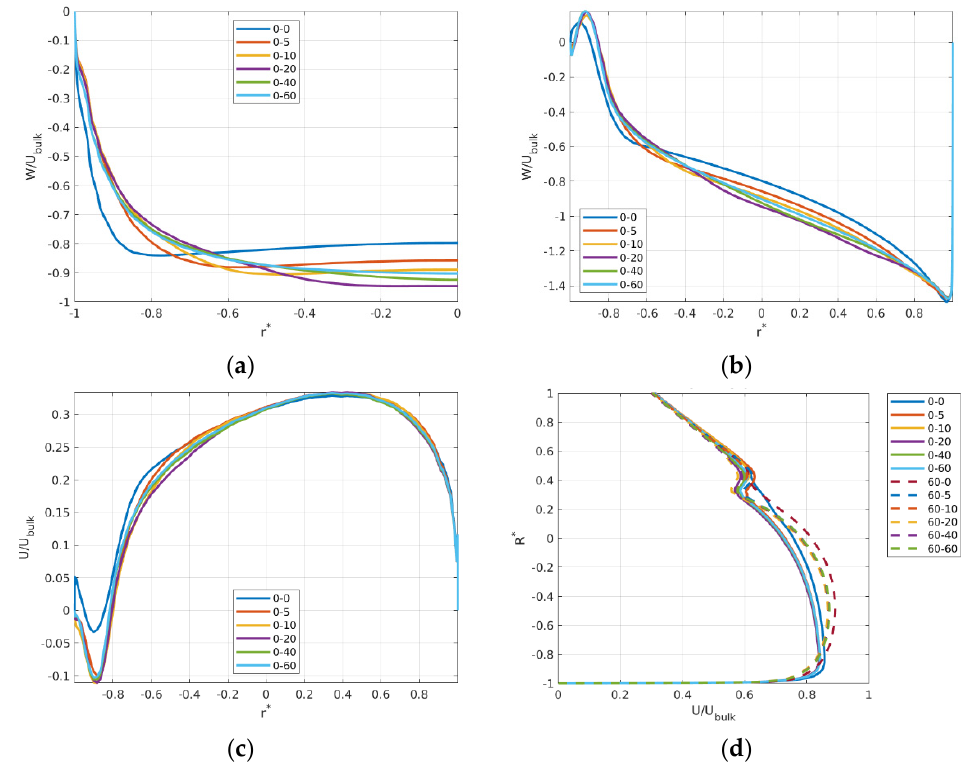
Figure 8. Profiles of ( a ) 𝑊 𝑈 (cid:3029)(cid:3048)(cid:3039)(cid:3038) ⁄ at 𝑧 = 0.07 m and 𝑥 = 0 and ( b ) 𝑊 𝑈 (cid:3029)(cid:3048)(cid:3039)(cid:3038) ⁄ at 𝑧 = 0.07 m and 𝑦 = 0, ( c ) 𝑈 𝑈 (cid:3029)(cid:3048)(cid:3039)(cid:3038) ⁄ at 𝑧 = 0.07 m and 𝑦 = 0—Cases with uniformly distributed BCs at the main inlet. ( c ) U / U bulk at z = 0.07 m and y = 0—Cases with uniformly distributed BCs at the main inlet. Subplot Subplot ( d ): vertical profiles of 𝑈 𝑈 (cid:3029)(cid:3048)(cid:3039)(cid:3038) ⁄ at 𝑥 𝐷⁄ = 0 for all cases. ( d ): vertical profiles of U / U bulk at x / D = 0 for all